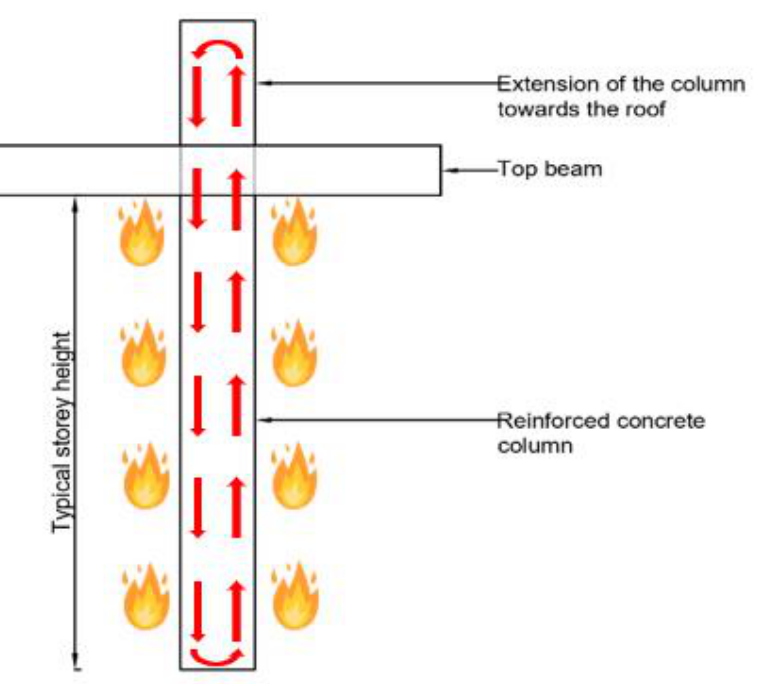
Figure 2. Conventional column under fire scenario .